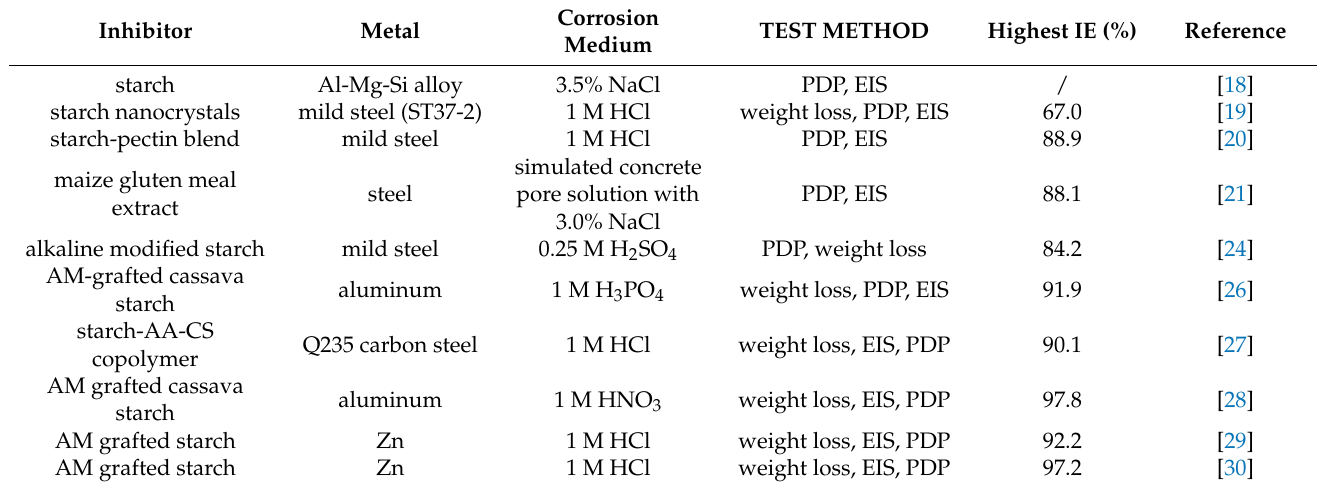
Table 1. Inhibition property of typical polymeric inhibitor from natural